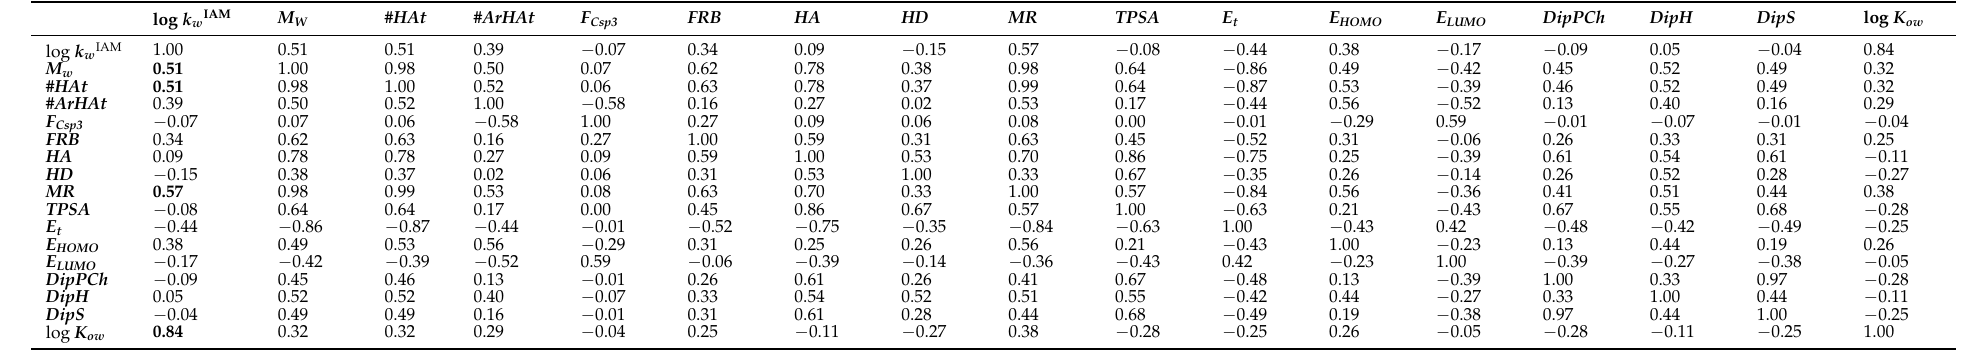
Table 4. Correlations between descriptors analyzed in this